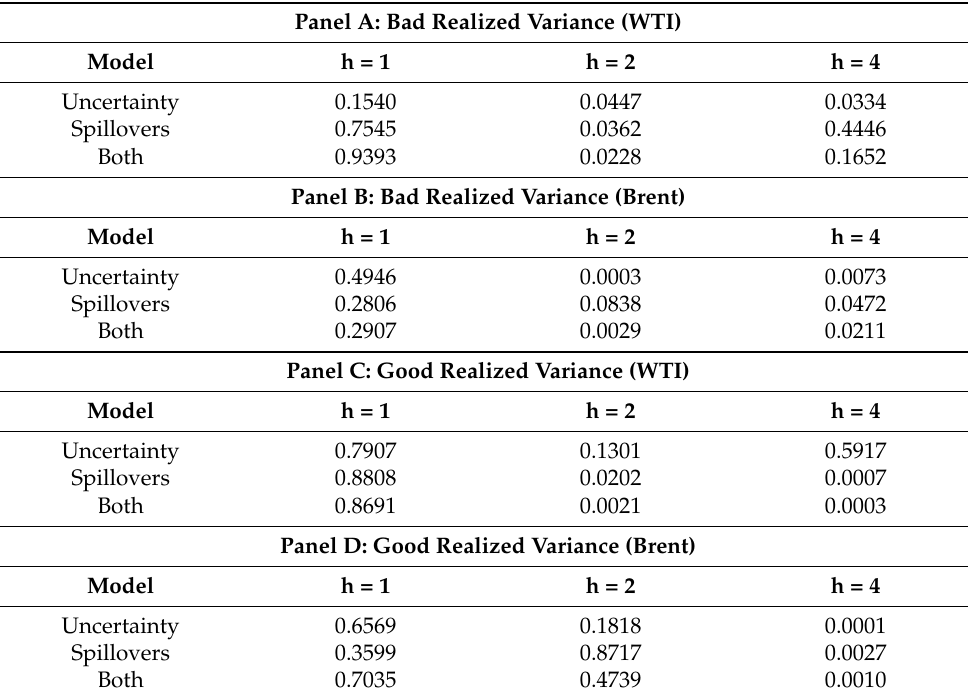
Table 3. Forecasting results for upside and downside